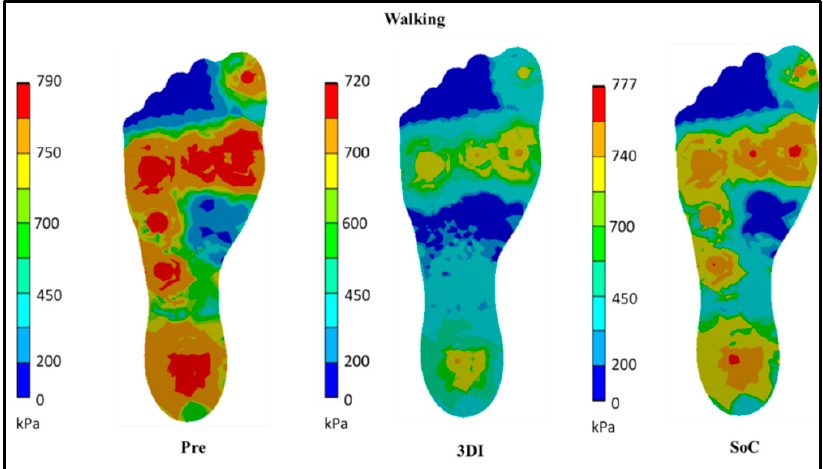
Figure 9. Pressure values taken in the walking position in 3D-printing-based group 1 ( A ) and standard-of-care insole group 2 ( B ) at seven different locations in the plantar region, 1: hallux, 2: first metatarsal, 3: third metatarsal, 4: fifth metatarsal, 5: medial mid-foot, 6: lateral mid-foot and 7: heel. The distributions of the walking plantar pressure are represented in Figure 10 for both the experimental as well as the control group. In the case of the experimental group, the peak values ranged from 259.33 to 714.66 kPa, whereas in the control group the values ranged from 338.44 to 776.66 kPa. Better improvements in the plantar pressures could be observed in the post-test scores of standing and walking plantar pressures in the 3D- printing-based customized insole group. The figures demonstrating the plantar pressure distribution also show evidence of these improvements.